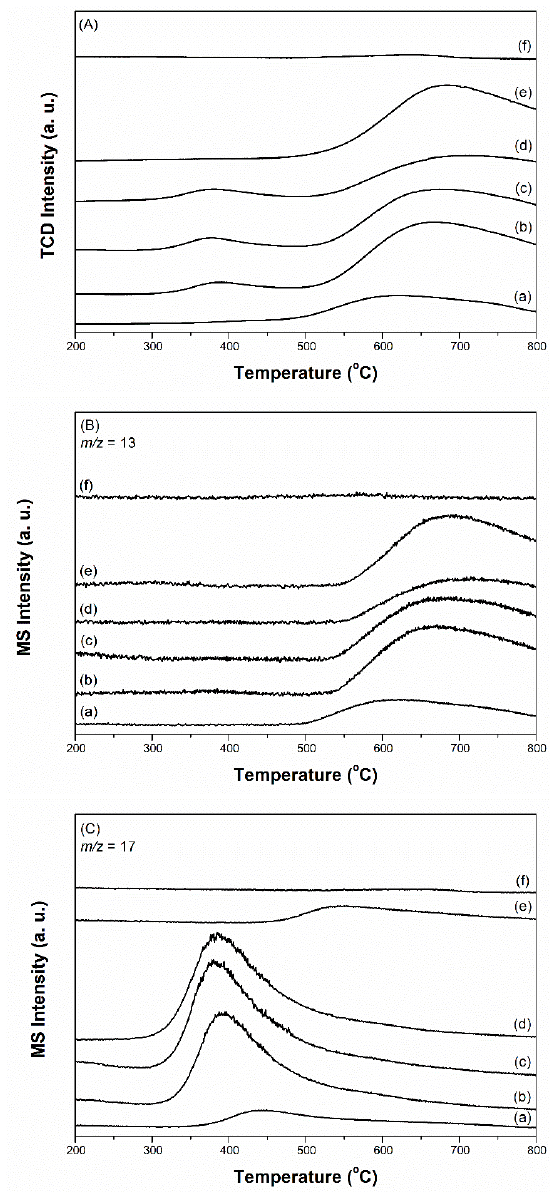
Figure 5 . (A) TPR-TCD profile, ( B ) TPR-MS profile recorded by a m/z ratio of 13, and ( C ) TPR-MS profile recorded by a m/z ratio of 17 for the ammonia synthesis over freshly prepared catalysts. (a) (a) 2.5Cs-10Ru / AC, (b) 2.5Cs-10Ru / MPC-15, (c) 2.5Cs-10Ru / MPC-18, (d) 2.5Cs-10Ru / MPC-21, (e) 10Ru / 2.5Cs-10Ru/AC, (b) 2.5Cs-10Ru/MPC-15, (c) 2.5Cs-10Ru/MPC-18, (d) 2.5Cs-10Ru/MPC-21, (e) 10Ru/MPC-18 and (f) 2.5Cs/MPC-18. MPC-18 and (f) 2.5Cs /